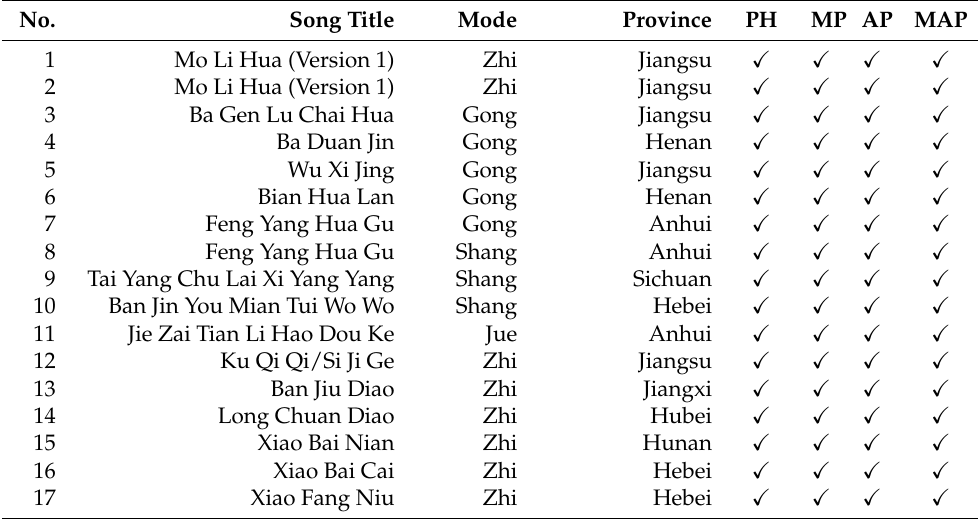
Table A1. Information (titles, pentatonic modes, and provinces of origin) on all the 53 traditional Chinese anhemitonic pentatonic songs we collected and whether their pitch distribution show a bell shape in various histograms. Hanyu Pinyin is used for the titles to make it easier for readers with Mandarin knowledge to identify the songs. The English title corresponding to each song’s Hanyu Pinyin can be found in Figures 1–6. PH: pitch histogram; MP: merged pitch histogram; AP: anhemitonic pentatonic pitch histogram; MAP: merged anhemitonic pentatonic pitch histogram; (cid:88) : comforming to a perfect bell shape ( DoBell =